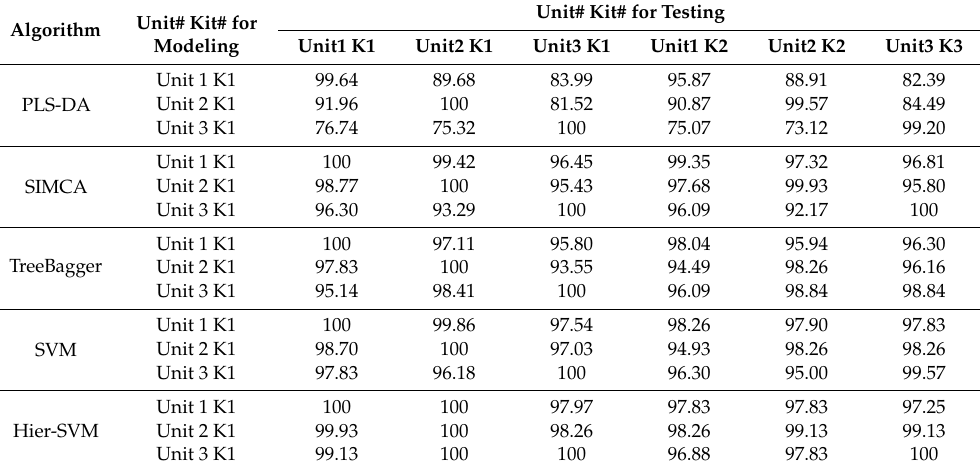
Table 1. Prediction success rates (%) of polymer